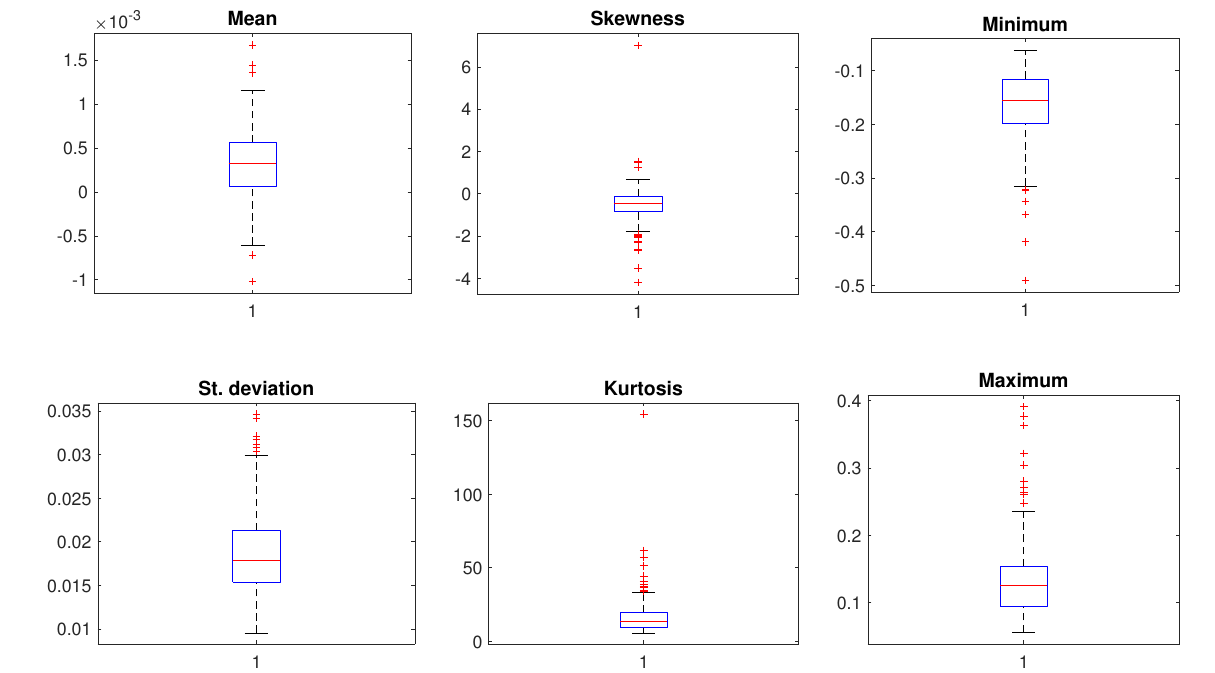
Figure 4. On the descriptive statistics of the returns of stocks in the S&P Europe 350 Index from January 2016 to December 2021. Source: Authors’